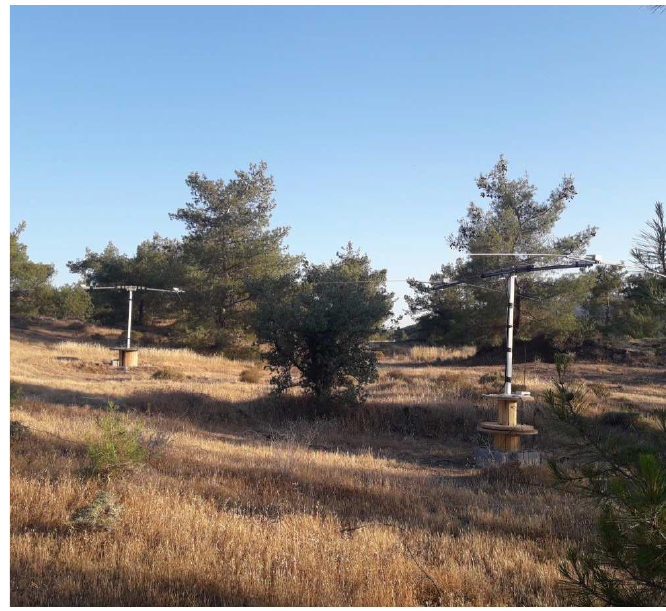
Figure 16. Deployed dipole phased-array system.